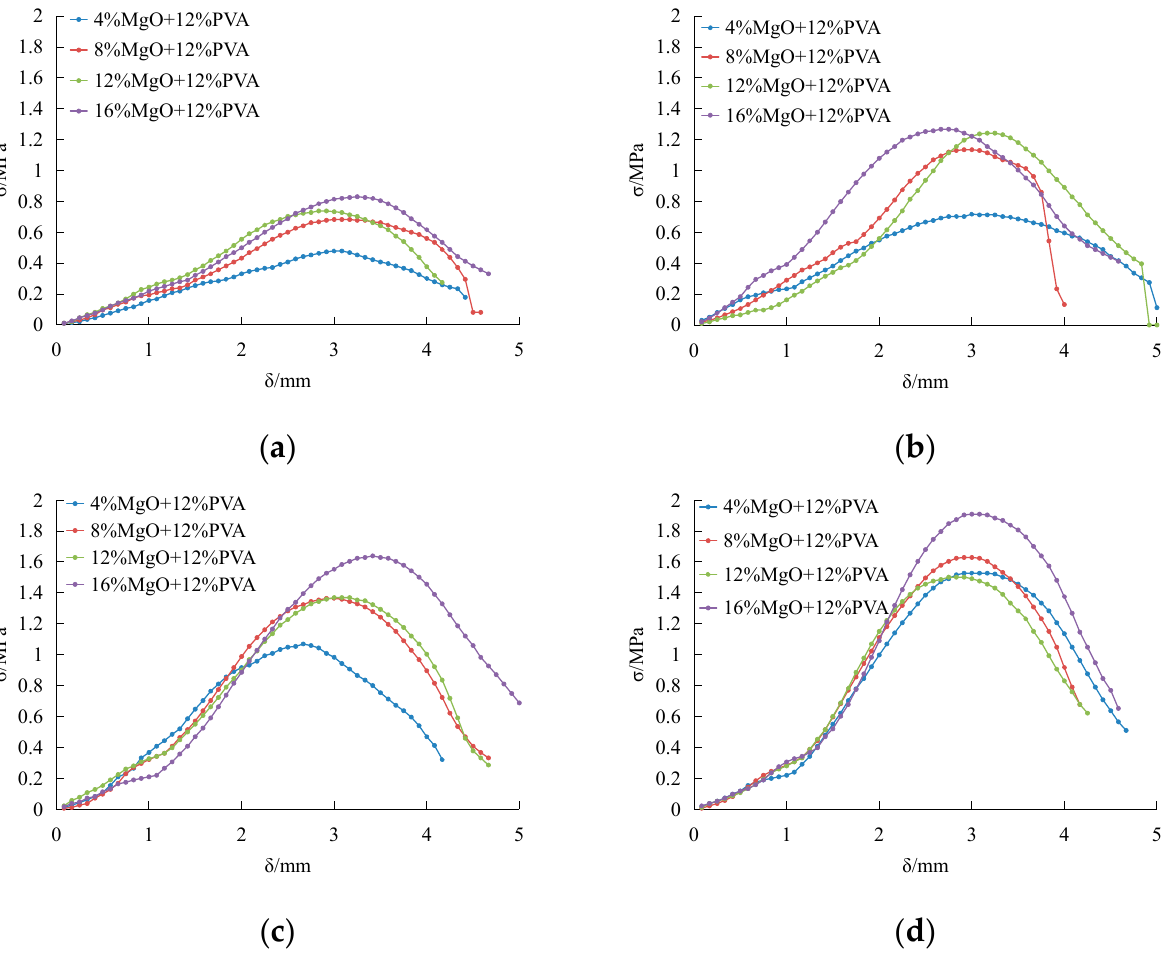
Figure 5. ( a ) 3 day; ( b ) 7 day; ( c ) 14 day; ( d ) 28 day. Stress–strain curve of PVA and activated magnesium oxide composite improvement.